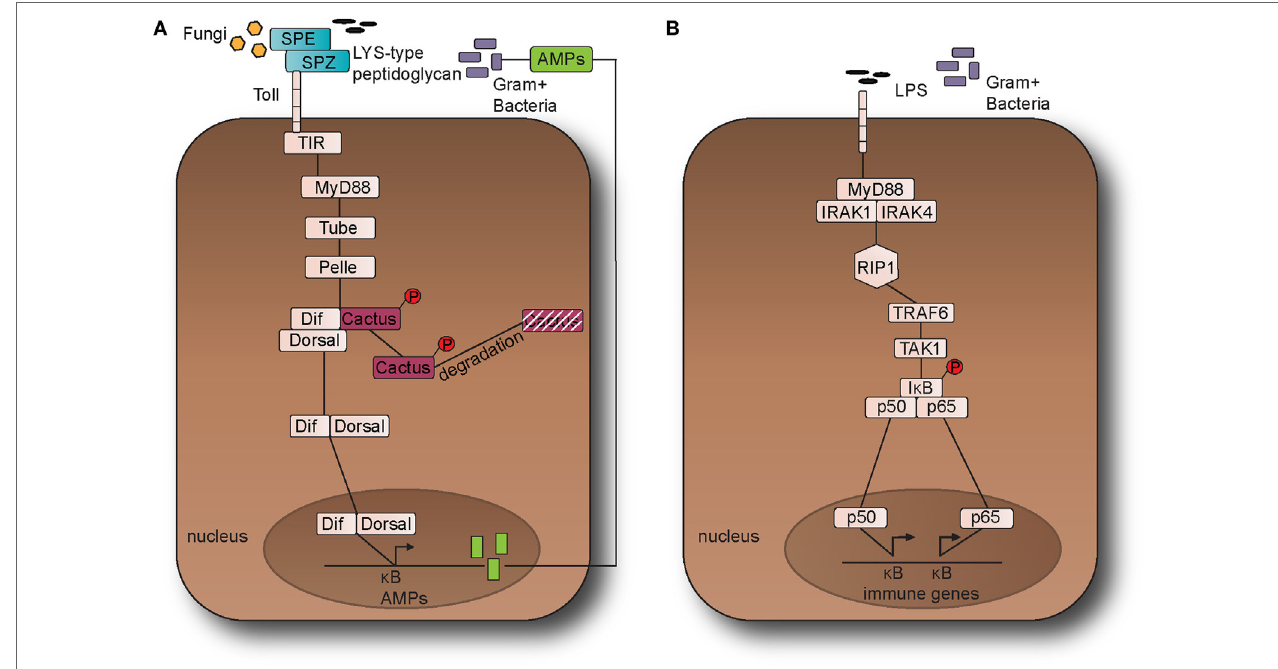
FiGURe 1 | The Toll pathway in fruit fly and the Toll-like receptor (TLR) 4 pathway in the mouse. (A) The Toll pathway in Drosophila melanogaster detects Gram- positive bacteria and fungi is activated through an endogenous ligand, namely Nerve Growth Factor-related cytokine Spaetzle (SPZ) which is processed by Spaetzle- processing enzyme (SPE). Toll receptor activation results in the recruitment of the adaptor proteins namely myeloid differentiation primary response 88 (dMyD88), Tube, and Pelle, which promotes signaling to Cactus and its ankyrin-repeat domains. Cactus is bound to the nuclear factor-kappa B (NF- κ B) transcription factors dorsal-related immunity factor (DIF) and Dorsal and following activation of the pathway, it is phosphorylated and degraded. The above signaling events result in the nuclear translocation of DIF or Dorsal that stimulate the transcriptional upregulation of antimicrobial peptide (AMP) genes, such as Drosomycin. (B) . TLR4 receptor in M. musculus detects lipopolysaccharides (LPS) from Gram-negative bacteria. Myeloid differentiation primary response 88 (MyD88) is recruited with Interleukin-1 receptor-associated kinases 1 and 4 (IRAK1, IRAK4), receptor-interacting protein 1 (RIP1), and tumor necrosis factor (TNF) receptor-associated factor 6 (TRAF6). TRAF6 is self-ubiquitinated in order to recruit transforming growth factor beta (TGF- β ) activated kinase 1 (TAK1) and TAK1-associated binding proteins 1 and 2 (TAB1 and TAB2). The latter leads to the activation of the I κ B kinase (IKK) complex that in turns phosphorylates the inhibitor of NF- κ B (I κ B). This leads to the release of NF- κ B that translocates to the nucleus and initiates the transcriptional induction of inflammatory and immune response related genes. This leads to the translocation of the NF- κ B transcription factors p50 and p65 to the nucleus, which in turns initiates the transcriptional induction of inflammatory and immune response related